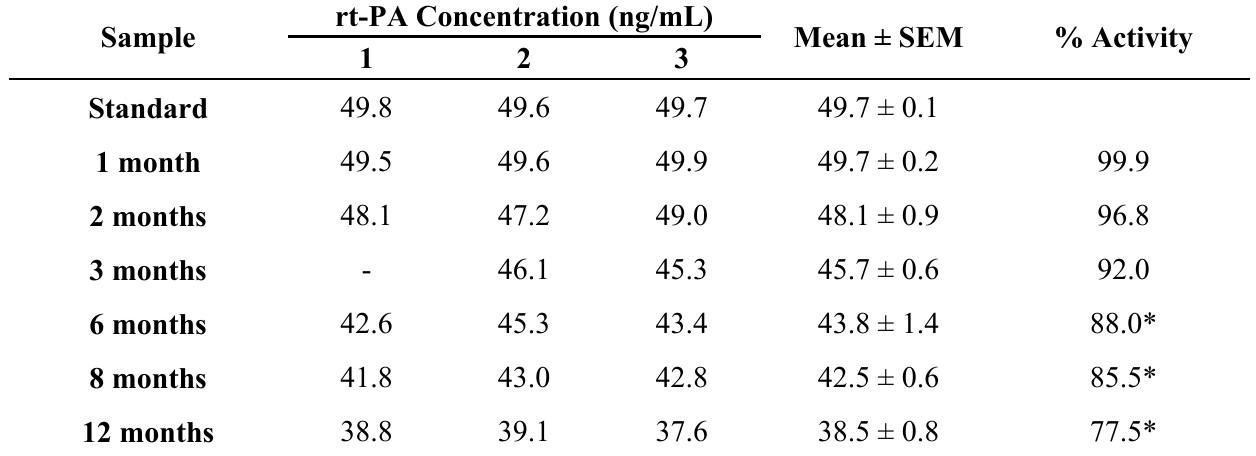
Table 1. Effect of freezing for 1 month and 2, 3, 6, 8 and 12 months at − 30 °C on the stability of